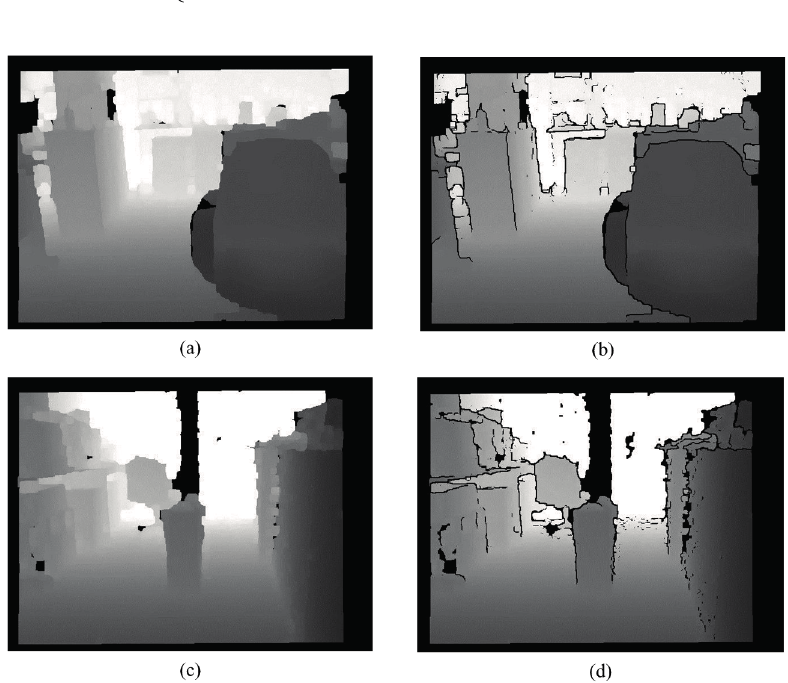
Figure 12. Removal of the edge. ( a ) Noiseless image; ( b ) Processing result; ( c ) Noiseless image; ( d ) Processing